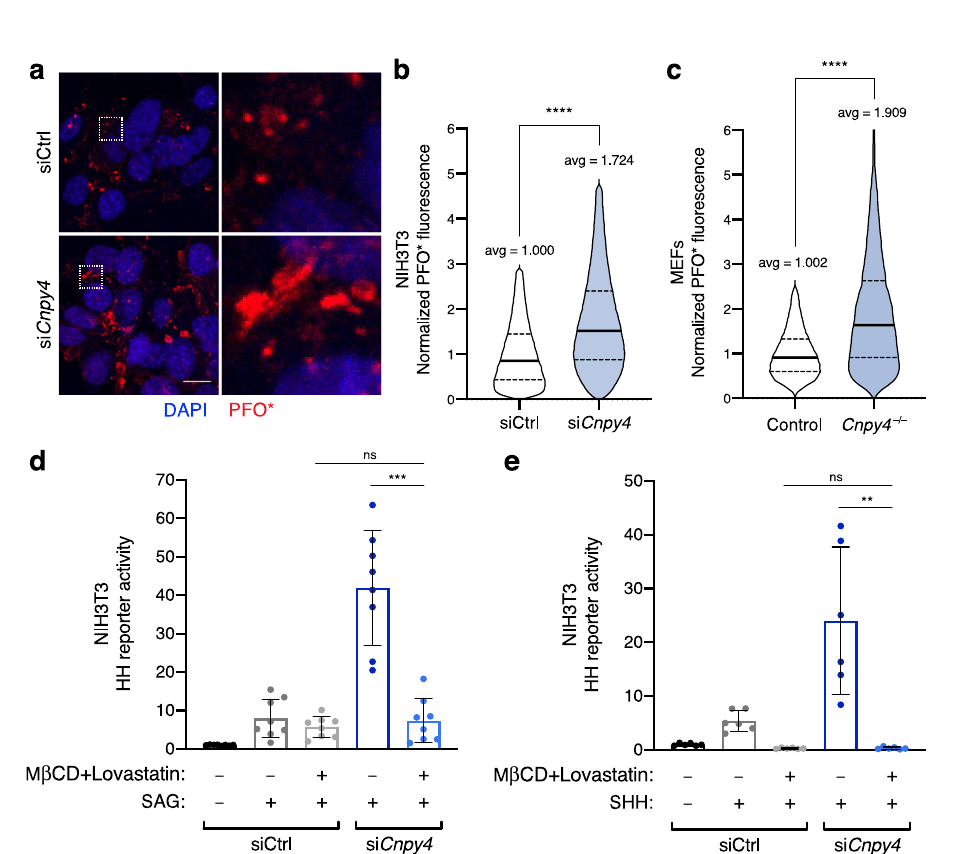
Fig. 3 CNPY4 intersects the HH pathway at the level of SMO. a Immuno fl uorescence-based staining of primary cilia (acetylated tubulin, red), SMO (SMO, green), and nuclei (DAPI, blue) in ciliated NIH3T3 cells treated with control or Cnpy4 siRNA. The scale bar represents 10 μ m. Cilia scale bar represents 1 μ m. b Quanti fi cation of the percentage of ciliated NIH3T3 cells, as assessed by acetylated tubulin immuno fl uorescence. Data represent the mean ± SEM ( n = 152 siCtrl cells and n = 110 si Cnpy4 cells from three biological replicates). Signi fi cance was calculated using a two-sided unpaired Welch ’ s t -test with ns p > 0.05 ( p = 0.5286). c Quanti fi cation of the length of cilia in NIH3T3 cells. Measurements were made in FIJI using the acetylated tubulin channel. Data represent the mean ± SEM ( n = 77 cells from three biological replicates). Signi fi cance was calculated using a two-sided unpaired Welch ’ s t - test with *** p < 0.001 ( p = 0.0002). d – g Luciferase reporter assay in ciliated Ptch1 ( d ), Sufu ( e ), or Smo ( f , g ) null MEFs treated with control (gray bars) or Cnpy4 (blue bars) siRNA. Smo null MEFs were stimulated with either SAG ( f ) or SHH ( g ). h , i Luciferase reporter assay in ciliated NIH3T3 cells treated with control (gray bars) or Cnpy4 (blue bars) siRNA stimulated with SAG ( h ) or SHH ( i ) in the presence of SMO antagonist (SANT-1). Data for d – i were normalized to the average value of control siRNA treated cells stimulated with DMSO where applicable. Data represent the mean ± SD ( n = 9 from three biological and three technical replicates). Signi fi cance was calculated using a two-sided Mann – Whitney non-parametric test with ns p > 0.05 ( p siCtrl + SAG similar results.